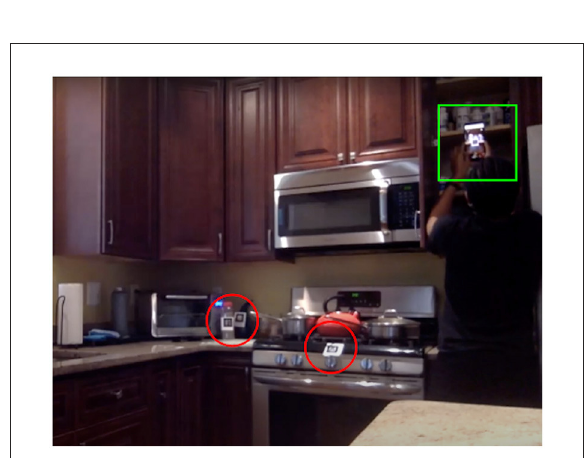
FIGURE2 User study in a participant’s own kitchen (markers circled in red, user scanning a marker squared in green).